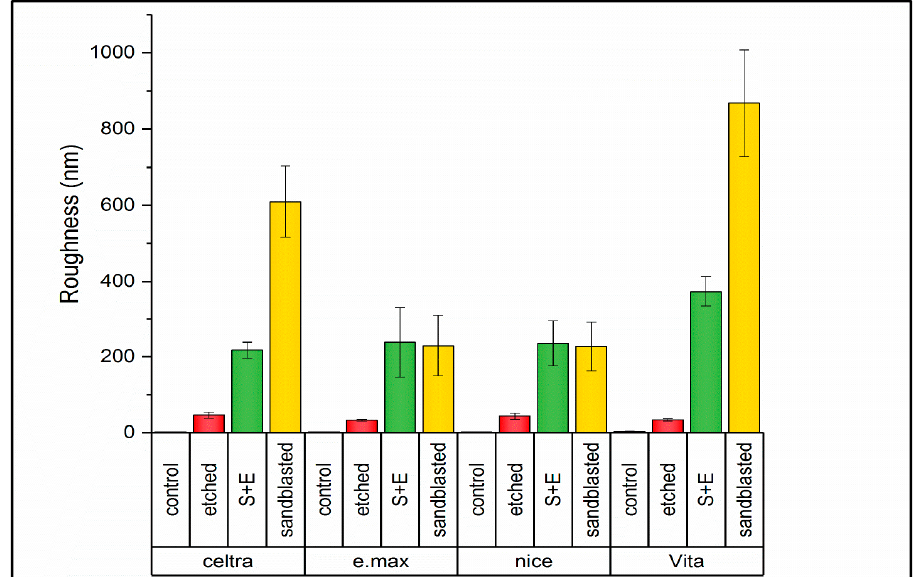
Figure 2. Atomic force microscopy images (AFM).). IPS e. max ® CAD ( 1 ) Vita Suprinity ® ( 2 ), Celtra Duo ® ( 3 ), n!ce ( 4 ). ( a ) Control, ( b ) HF, ( c ) SB, ( d ) SB + HF.